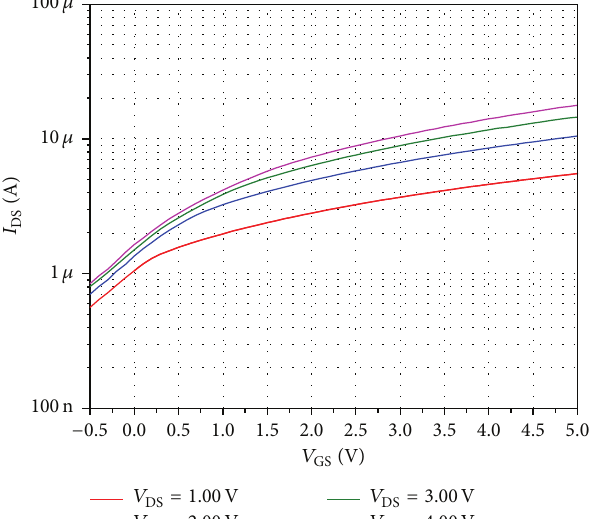
Figure 2: Transfer characteristics 𝐼 DS versus 𝑉 GS for GRC device with specifications: 𝑡 Si = 2.2 nm and 𝑊/𝐿 = 80 𝜇 m/3 𝜇 m, 𝑇 = 300